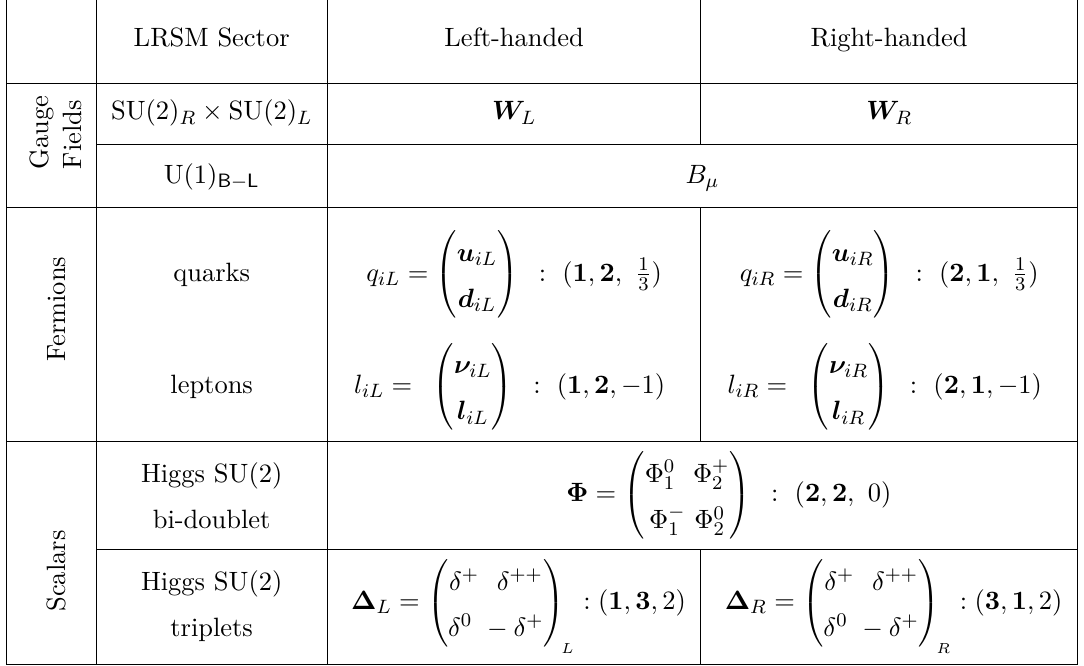
Table 2 . The field content of the minimal Left-Right Symmetric Model (LRSM) extension of the